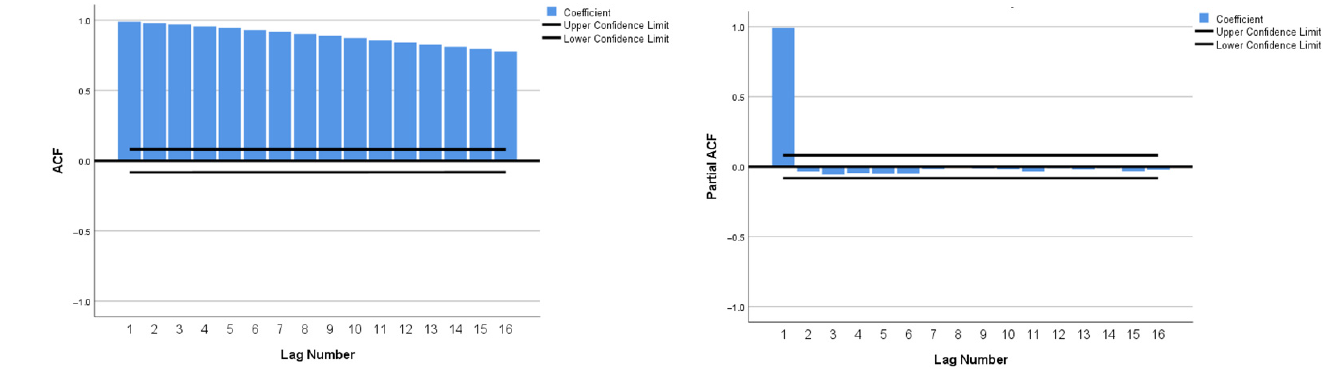
Figure A1. COVID-19 case trends (22 January 2020–5 September 2021), Malaysia.